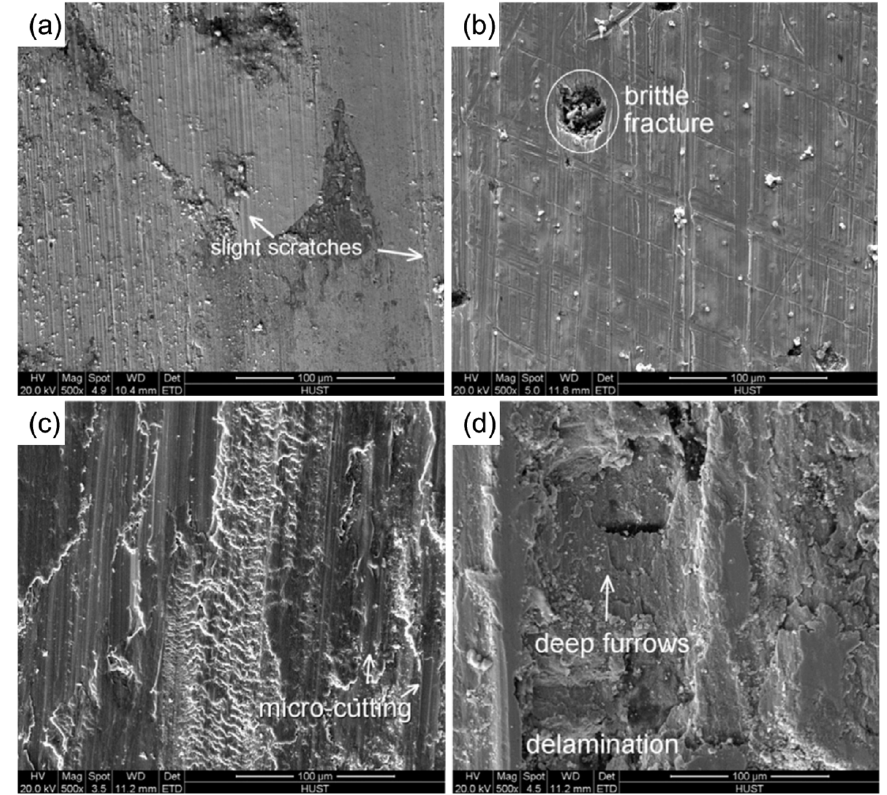
Figure 12. SE-SEM images showing wear morphologies of different samples (200 N): ( a ) PTA-alloyed HVHSS coating; ( b ) PTA-remelted; ( c ) Mn13 steel; ( d ) DI substrate [40].